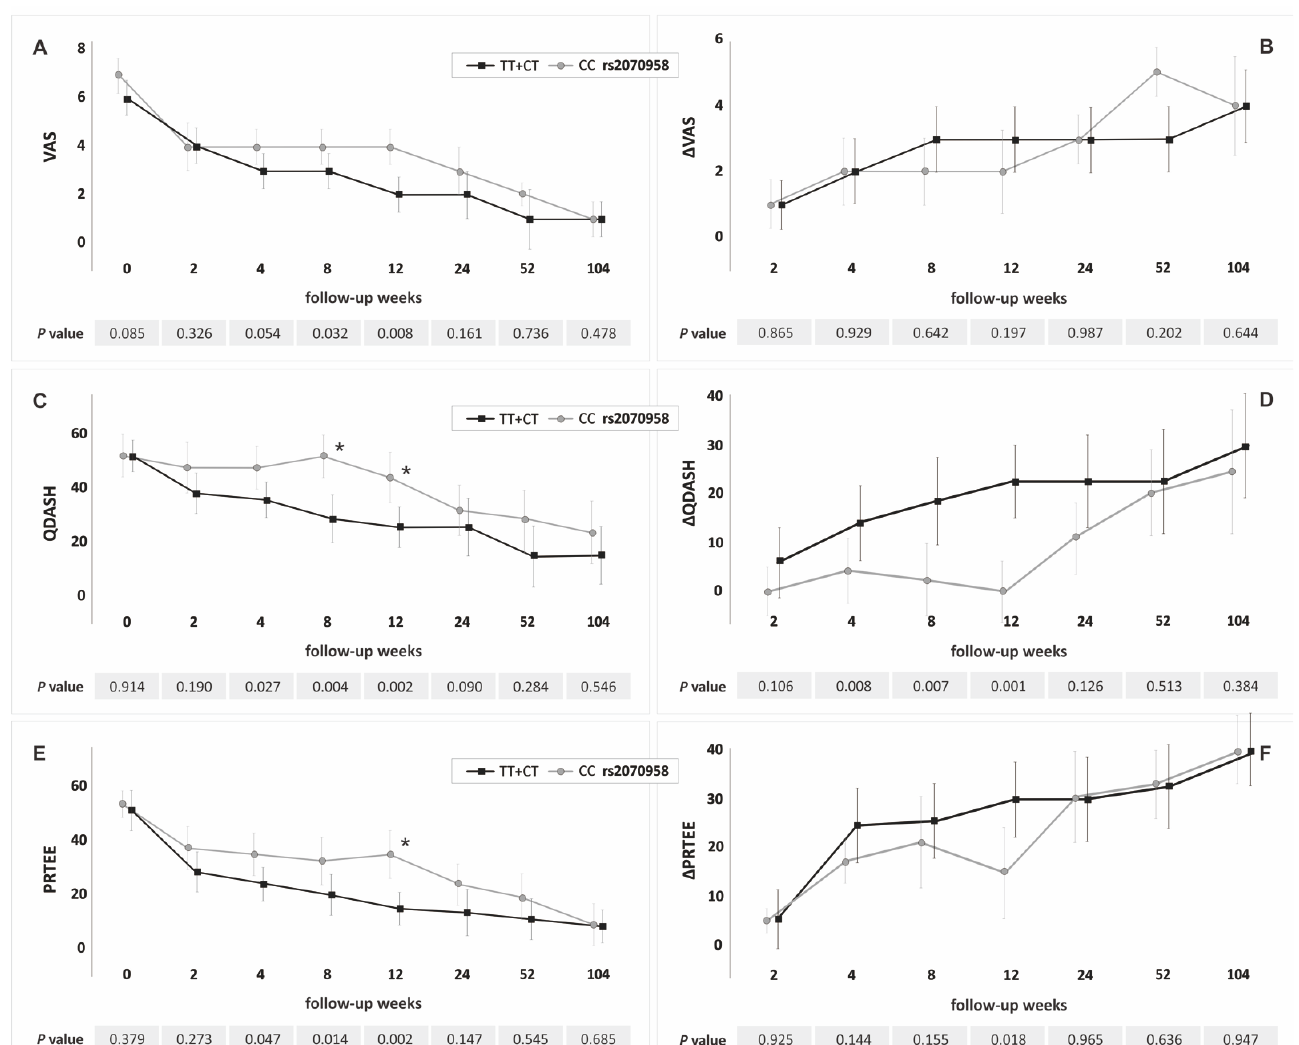
Figure 3. Medians (± QD) of PROMs values in respect to genotype variants of the PDGFA gene rs2070958 polymorphism (recessive/dominant model): ( A ) for VAS; ( B ) for ΔVAS; ( C ) for QDASH; ( D ) for ΔQDASH; ( E ) for PRTEE; ( F ) for ΔPRTEE. * Statistically important differences ( p < 0.050) in the percentage of patients who exceeded minimally clinically important difference (MCID). Legend: QD, quartile deviation; PROM, patient-reported outcome measure; VAS, visual analog scale; QDASH, quick version of disabilities of the arm, shoulder and hand score; PRTEE, patient-rated tennis elbow evaluation.